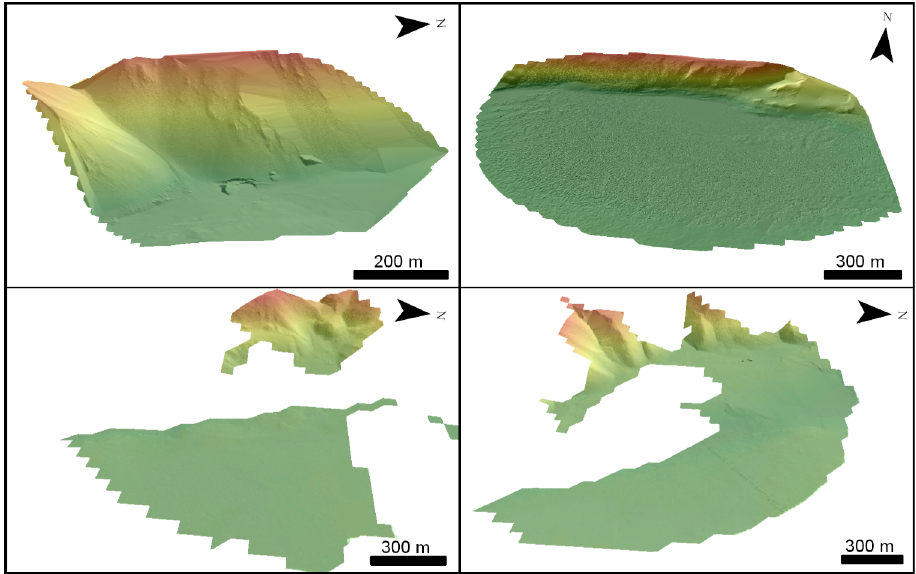
Figure 3. Perspective view of the covered relief of the four terrestrial laser scanning (TLS)-derived elevation raster datasets. Depicted relative altitudes of the raster datasets are from low (green) to high (red).